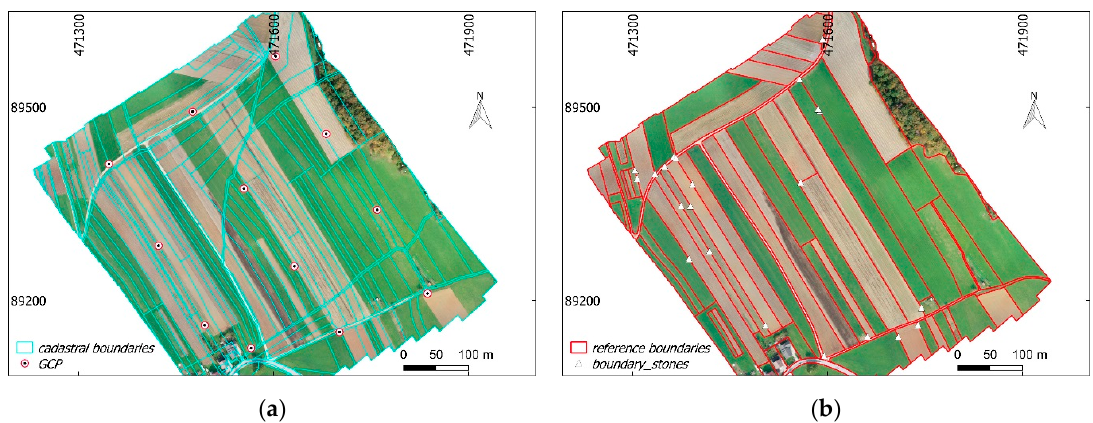
Figure 1. ( a ) Cadastral map and ground control points (GCPs). ( b ) Manually delineated object visible boundaries used as reference data to determine the detection/extraction quality. ( a , b ) Overlaid on UAV orthoimage of Ponova vas, Slovenia (EPSG 3794).